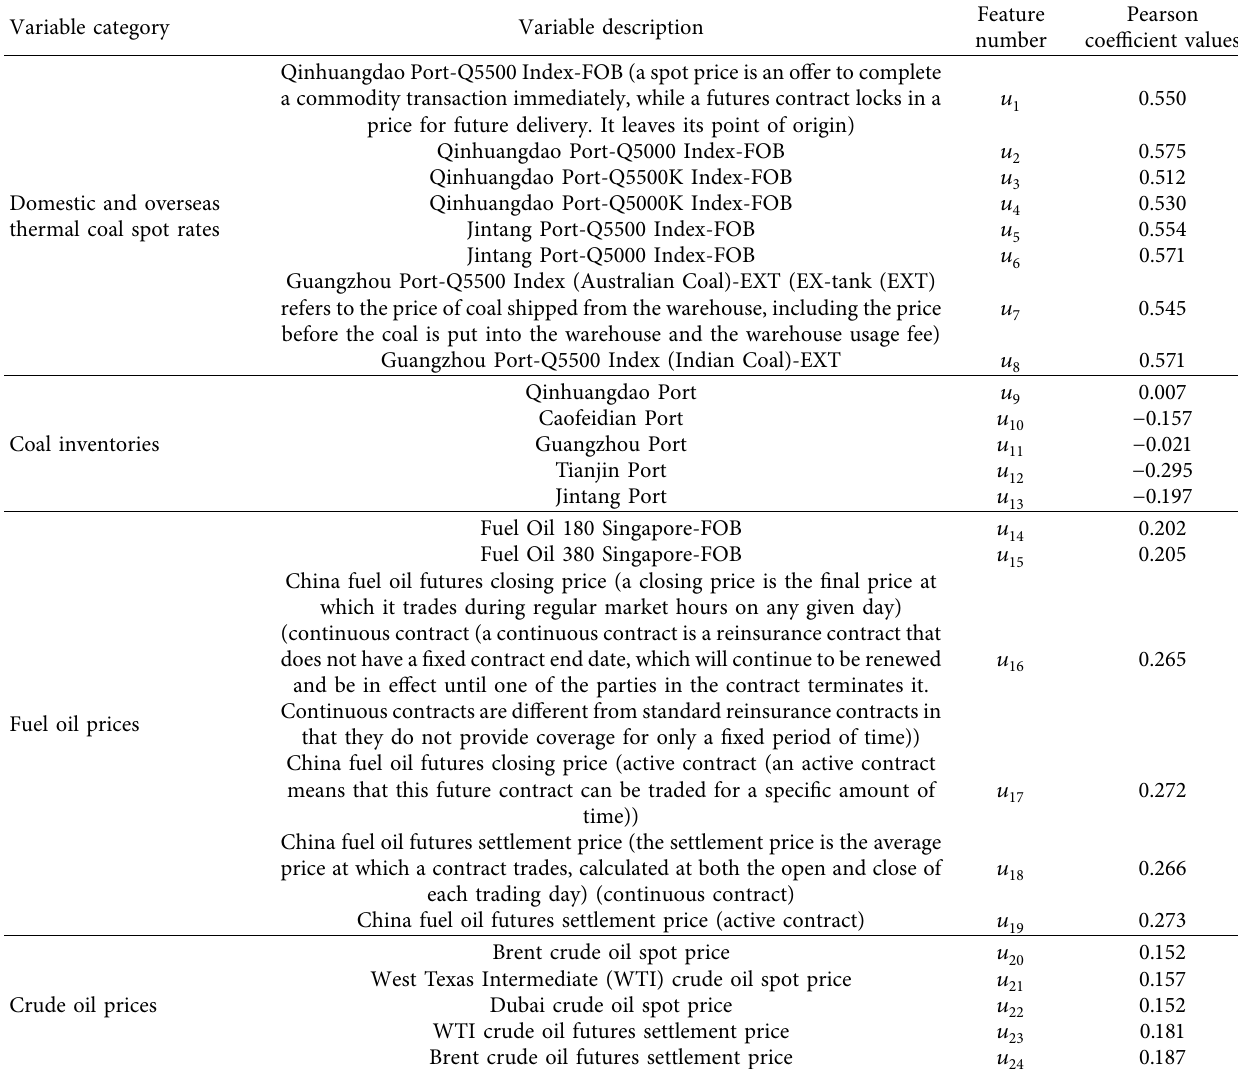
Table 2: Impact factors description and the corresponding Pearson coefficient